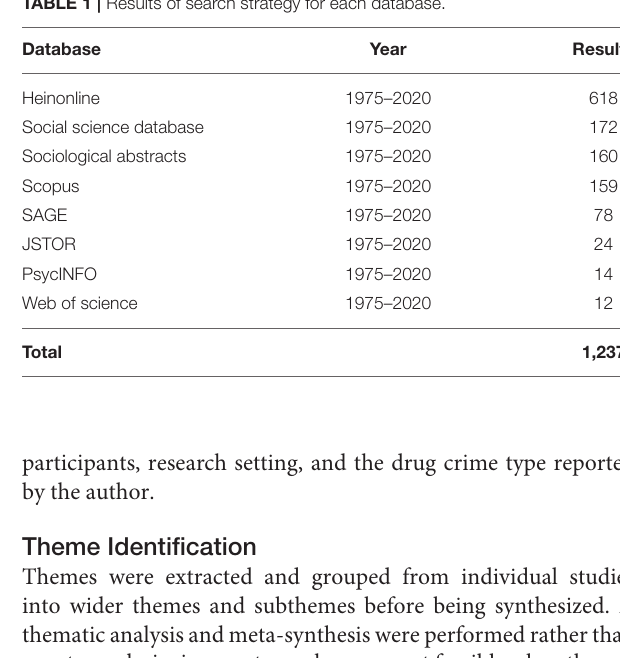
TABLE 1 | Results of search strategy for each database. TABLE 2 | Restrictive deterrence domains and strategy used by drug offenders.